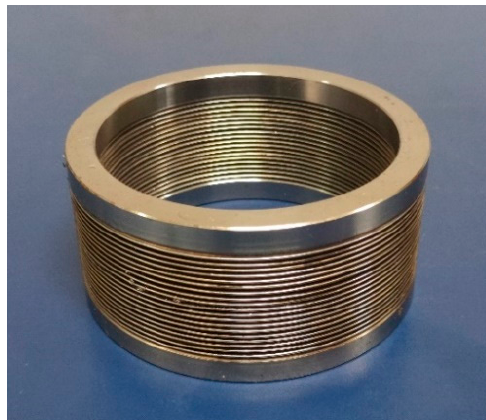
Figure 3. Bellow sample drawing .